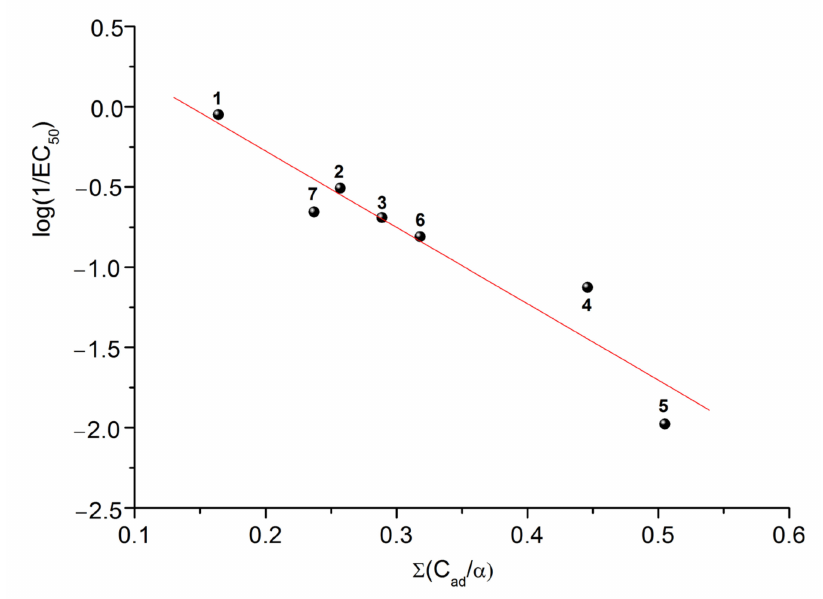
Figure 6. Dependence of log ( 1/ EC 50 ) versus Σ ( C ad / α ) descriptor (compounds numbering corre- sponds to Figure